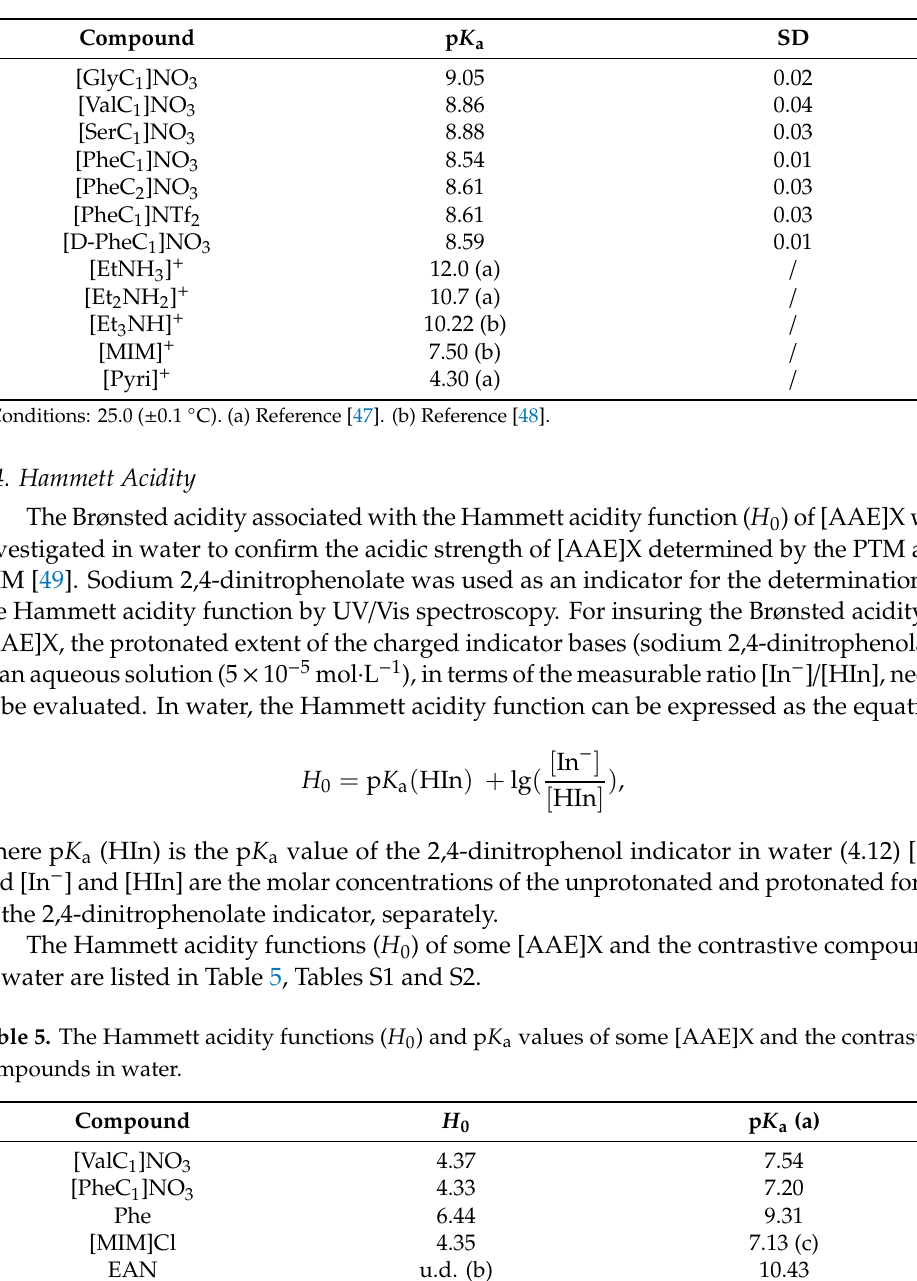
Table 4. The p K a values of [AAE]X and the contrastive compounds in ethanol.